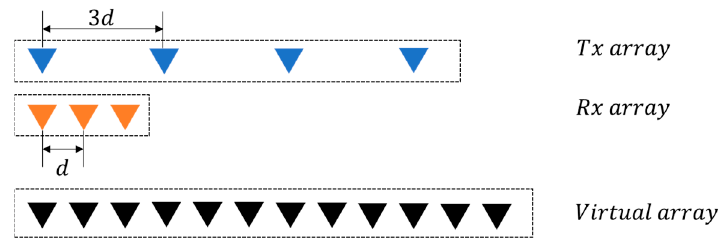
Figure 5. MIMO virtual array example where 𝐿 (cid:3047) = 4 and 𝐿 (cid:3045) = 3 .